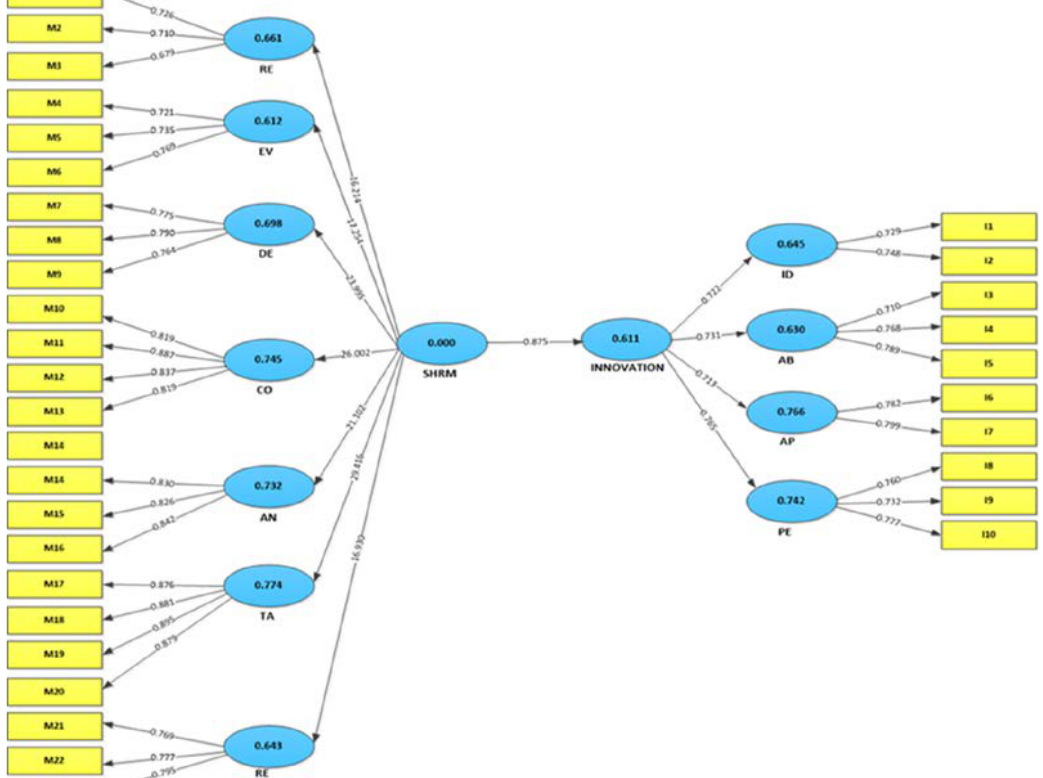
Fig. 2: Structural model of research in standard mode